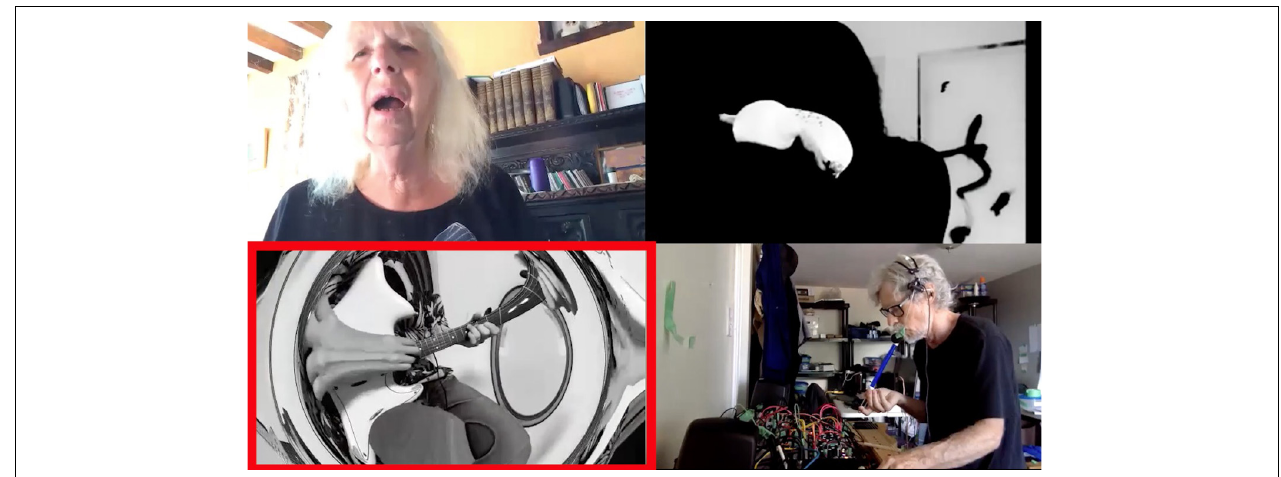
FIGURE 5 | Player/instrument